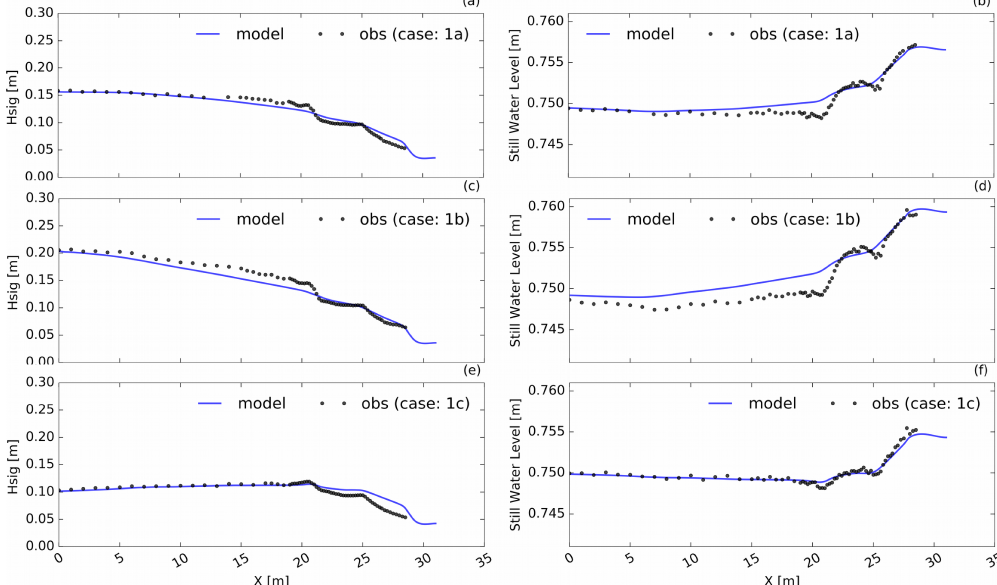
Figure 10. Significant wave height ( a , c , e ) and wave setup ( b , d , f ) for three different wave conditions which are summarized in Table 3. All model configurations and results are pre-decisional and for official use